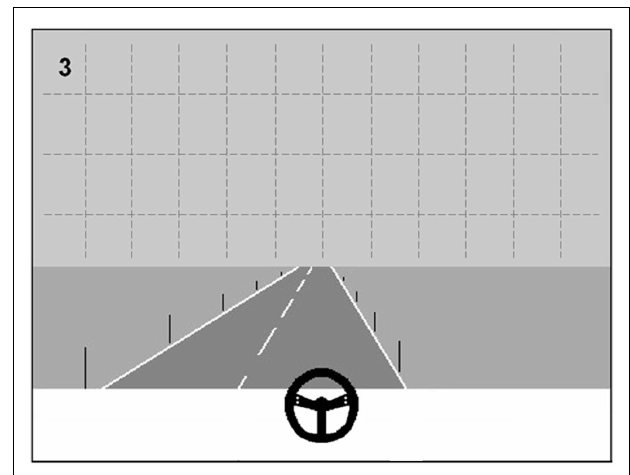
FIGURE 2 | CVRT-TR driving scene with digit projected at one of 48 possible locations